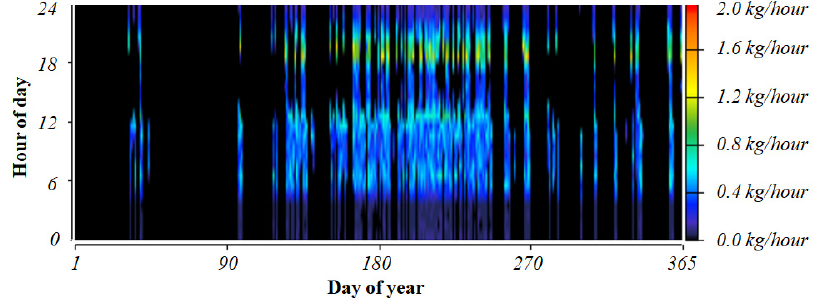
Figure A4. Electrolyser input power in HEGS combination 3.